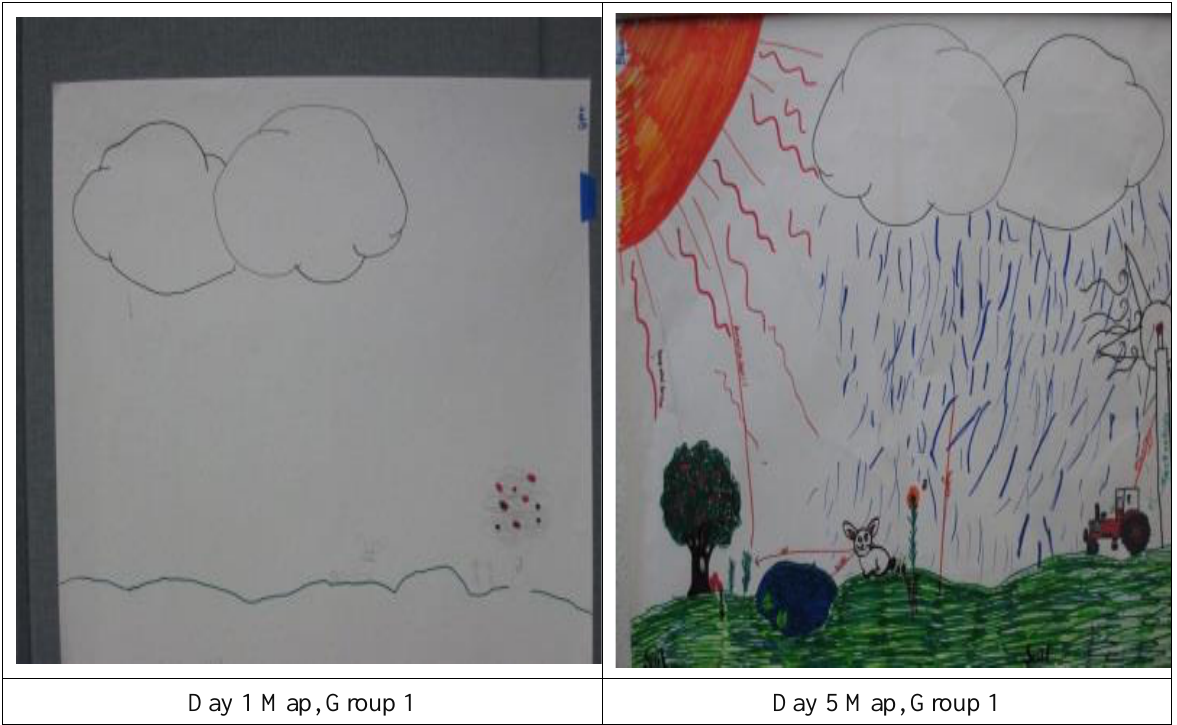
Enlarged Images From Figure 2: Students’ Maps of Their Understanding of Farm System Components Before and After Attending